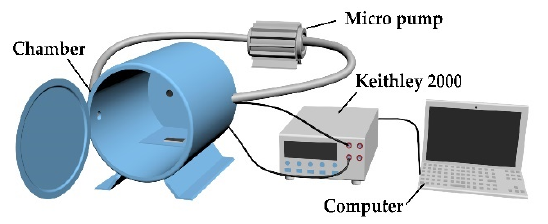
Figure 2. Schematic diagram of the gas-sensing test system.